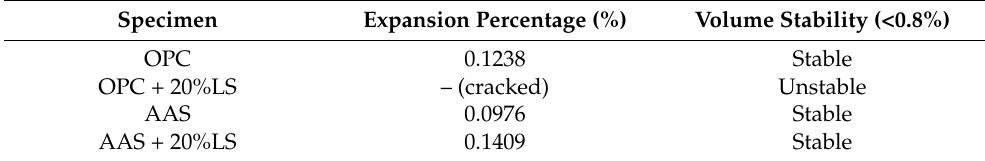
Figure 2. Specimens for autoclave expansion tests ( a ) before autoclave and ( b ) after autoclave. Table 3. Length comparison of autoclaved specimens with/without ladle slag (LS)